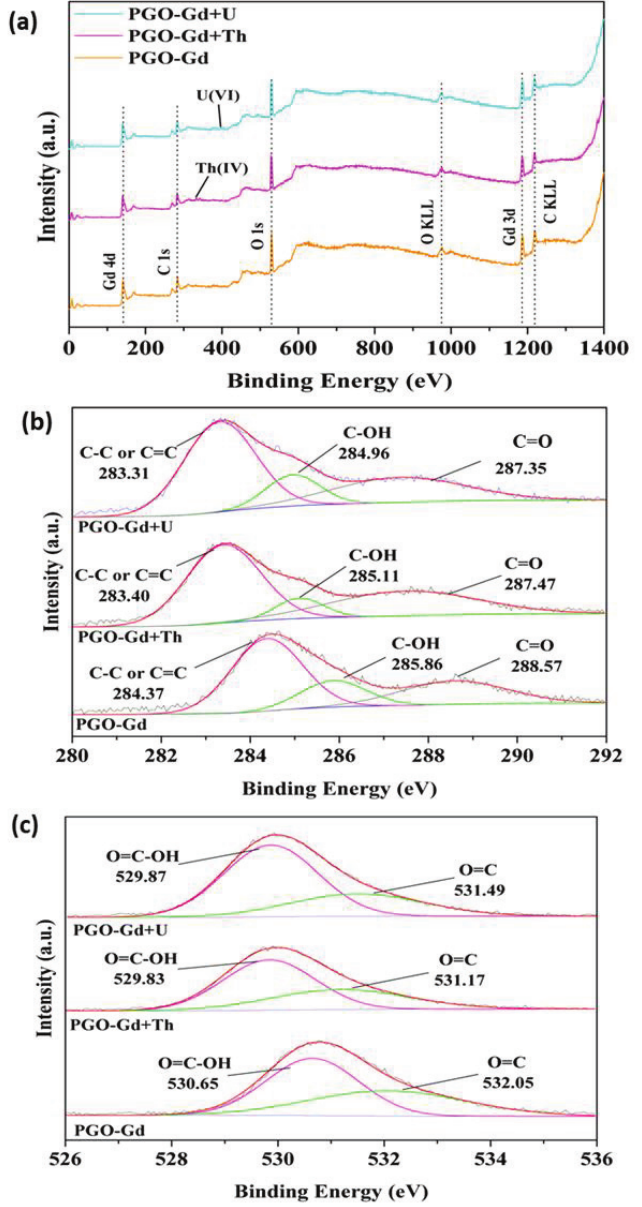
Figure 5. ( a ) Full XPS spectra of PGO–Gd. High resolution XPS of ( b ) carbon and ( c ) oxygen for U (VI) and Th(IV) adsorbed on PGO–Gd.